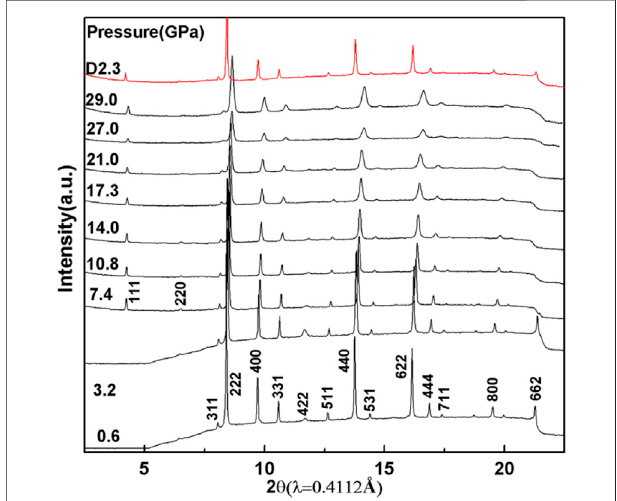
FIGURE 2 | Angle-dispersive XRD patterns of In 2 Mn 2 O 7 at selected pressures with a monochromic wavelength of0.4112 Å at room temperature. The top red pattern was taken from the samples after the release of pressure.